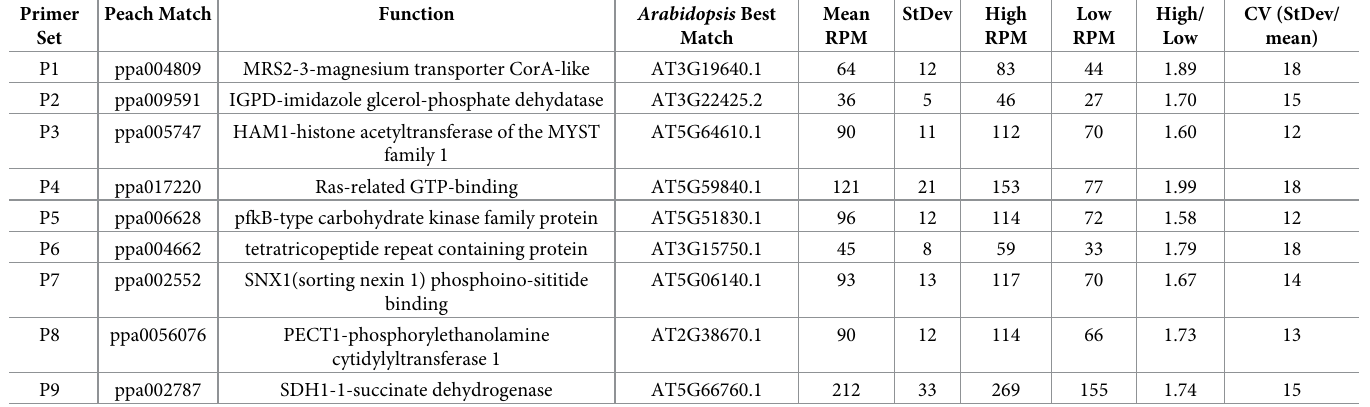
Table 2. Candidate reference genes derived from RNAseq plum fruit